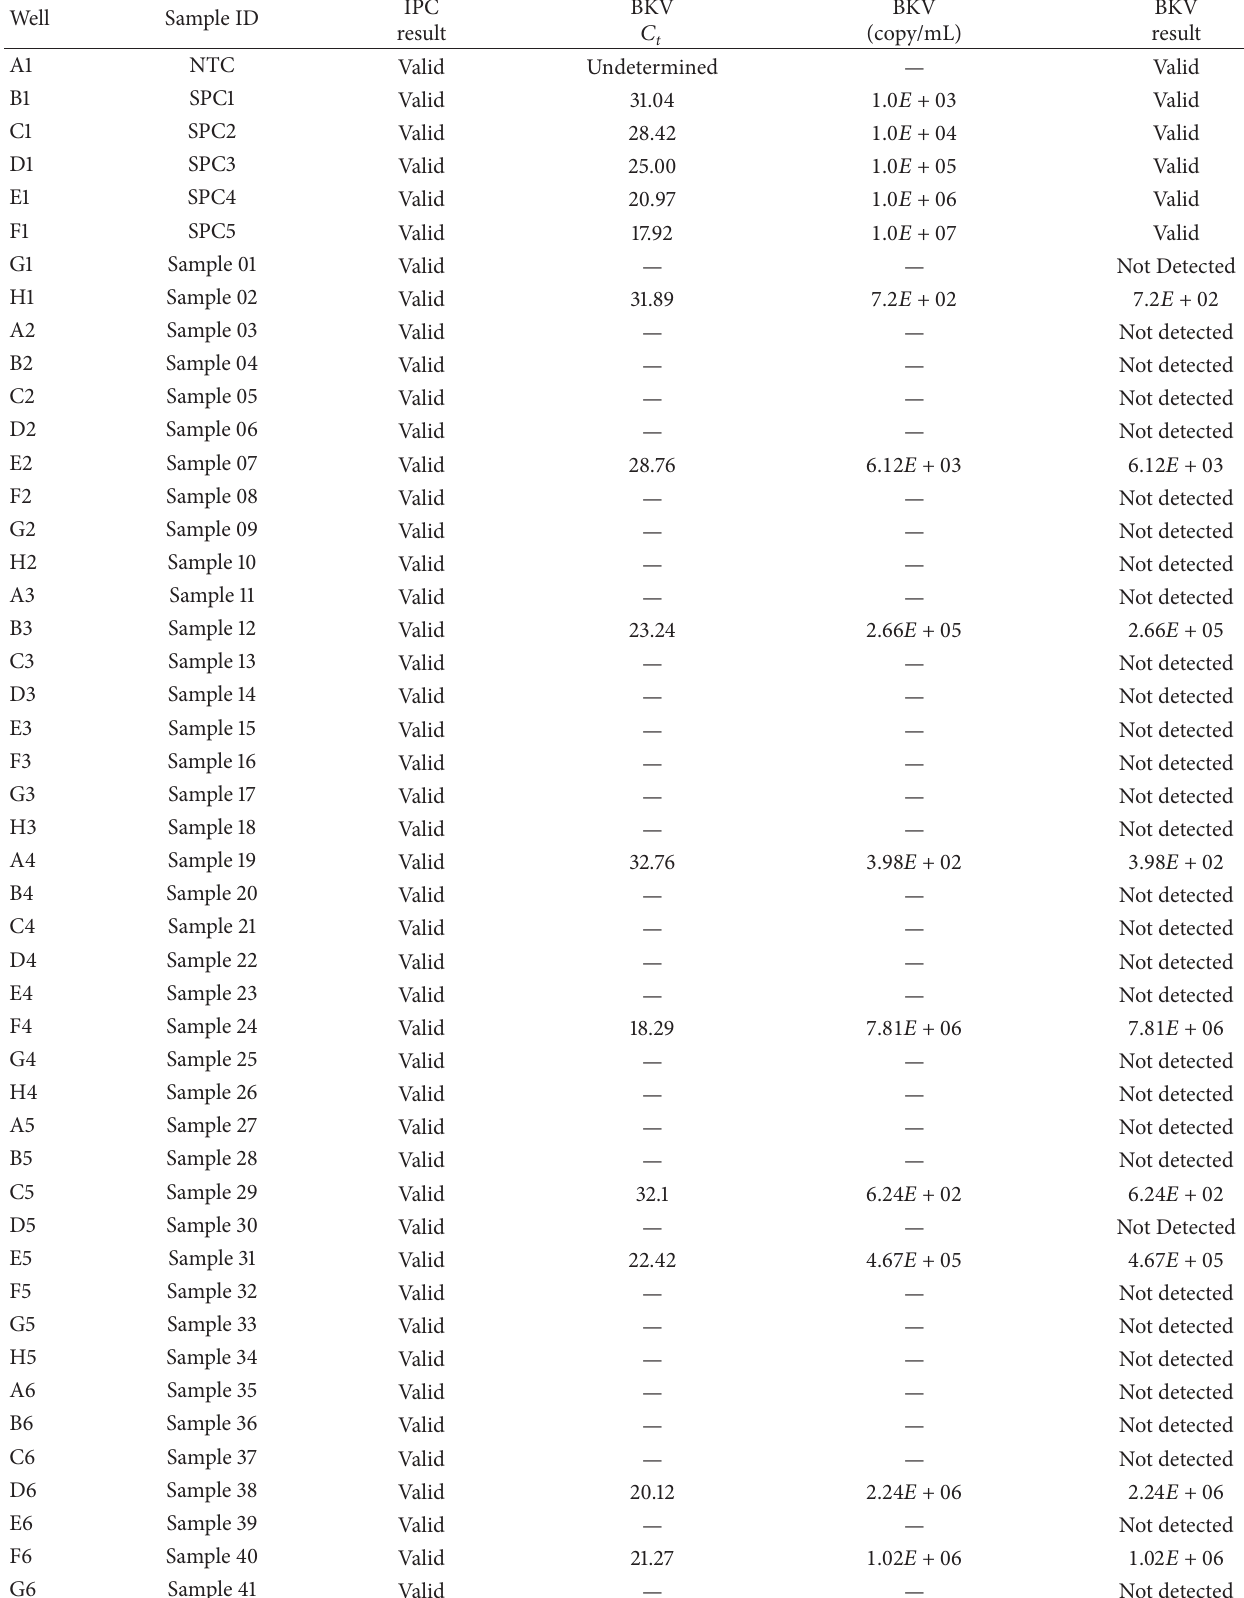
Table 3: BK virus load in renal transplant